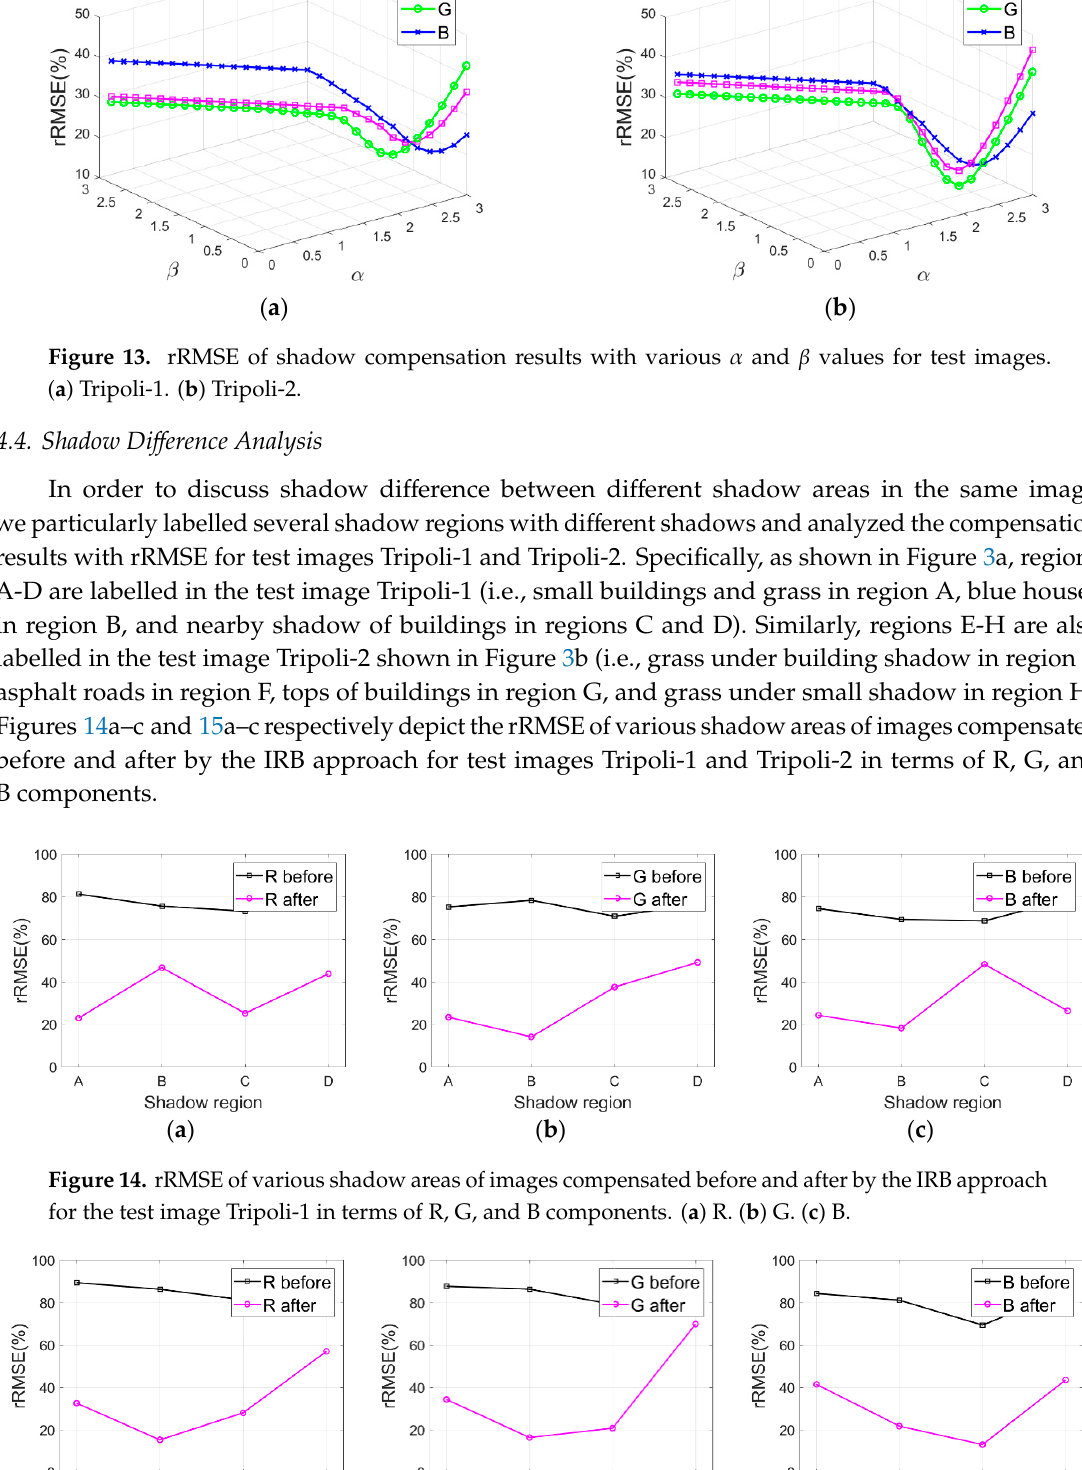
( b ) Figure 12. rRMSE of shadow compensation results with various α β+ values for test images. ( a ) Tripoli-1. ( b ) Tripoli-2. Additionally, the sensitivity of refining parameters α and β are further analyzed by valuing α and β from 0.1 to 3 with an interval of 0.1 in the additional experiments with test images Tripoli-1 and Tripoli-2. Figure 13a,b depict rRMSE of shadow compensation results with various α and β values for test images Tripoli-1 and Tripoli-2 in terms of R, G, and B components, respectively. As presented in Figure 13a,b, lower rRMSE values are acquired for test